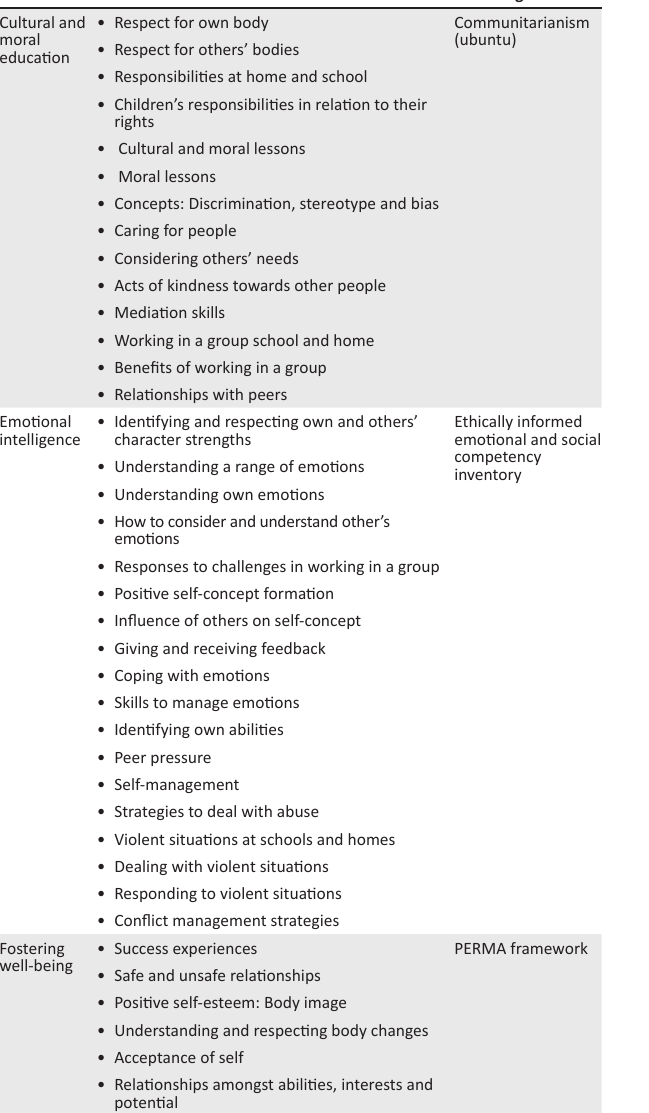
FIGURE 1: A conceptual framework for teaching personal and social well-being through musicking in the intermediate phase life skills class.